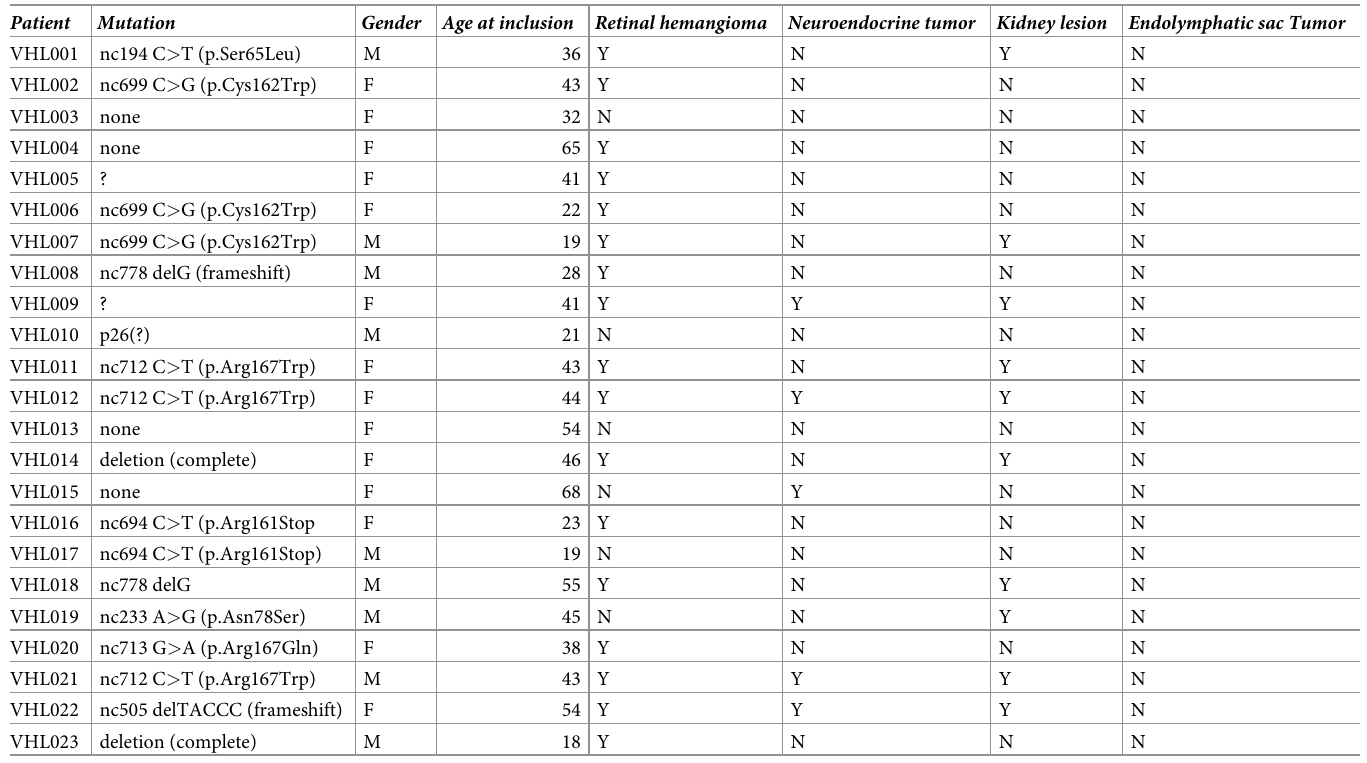
Table 1. Patients and clinical